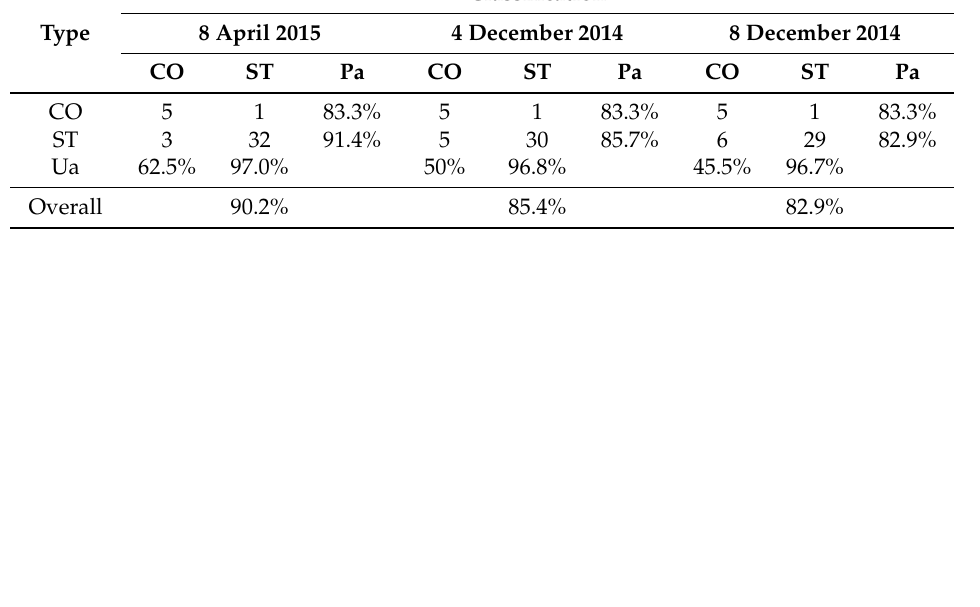
Table 4. Classification results with all features (CO = totally collapsed building, ST = standing building; Pa = producer’s accuracy, Ua = user’s accuracy).